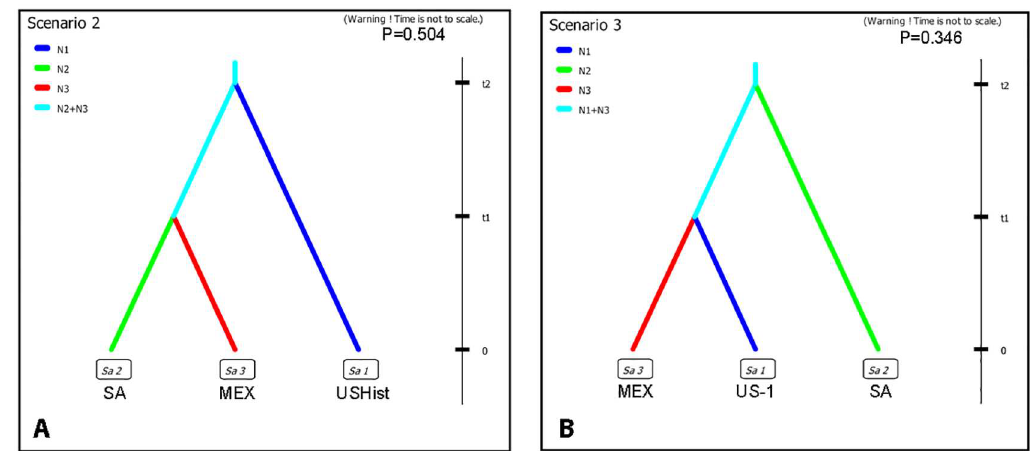
Fig 6. Scenarios for the evolution of Phytophthora infestans from sampled populations using Approximate BayesianComparison. Posterior probabilities of the top migration scenarioscomparing populationsfrom (A) US Historic (USHist), South American(SA) and Mexican (MEX) populations,and (B) US-1, MEX and SA populations. Probabilities are the highestvalue of a logistic regressionof